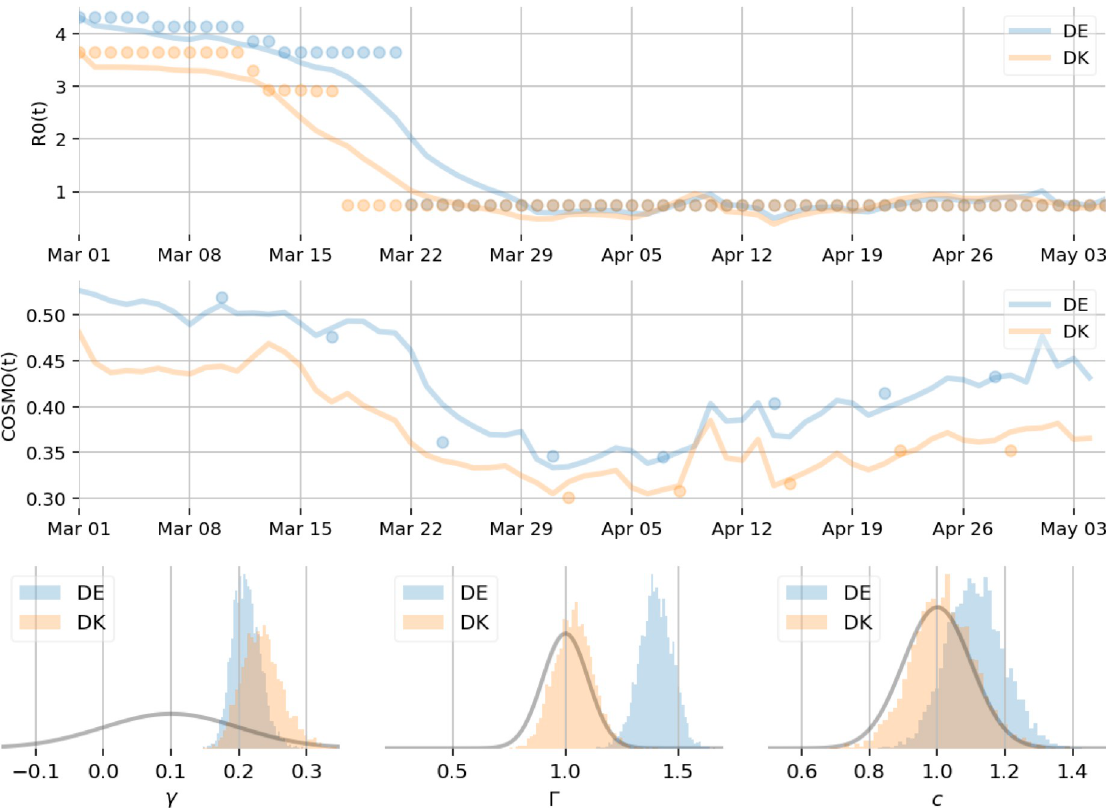
Fig 3. Inference of PS-SIR model parameters. Top : time series are shown for R(t), time varying reproduction rate estimates (see Fig 2), for Germany (DE) and Denmark (DK) in blue and orange circles, respectively, and the fit of the model as lines with the same color scheme. Middle : time series are shown for COSMO AFFECT data, for Germany and Denmark in blue and orange circles, respectively, and the fit of the model as lines with the same color scheme. Lower values indicate higher negative affect such as more fear and worries due to the Coronavirus. Bottom : MCMC posterior distributions for key model parameters ( γ : coupling strength of g i ; Γ : time scale of psychosocial accumulation; c : coupling strength of f i ) for Germany and Denmark (blue and orange histograms, respectively) and their respective priors (grey lines). On the left, the histograms of posterior samples for γ for both countries, which deviate significantly from the prior (grey line); the data thus identify a strong and robust effect of PS factors on SIR dynamics. Similar effects are seen for Γ and c for Germany, while Denmark follows the prior on these parameters likely because of missing COSMO data at the onset of